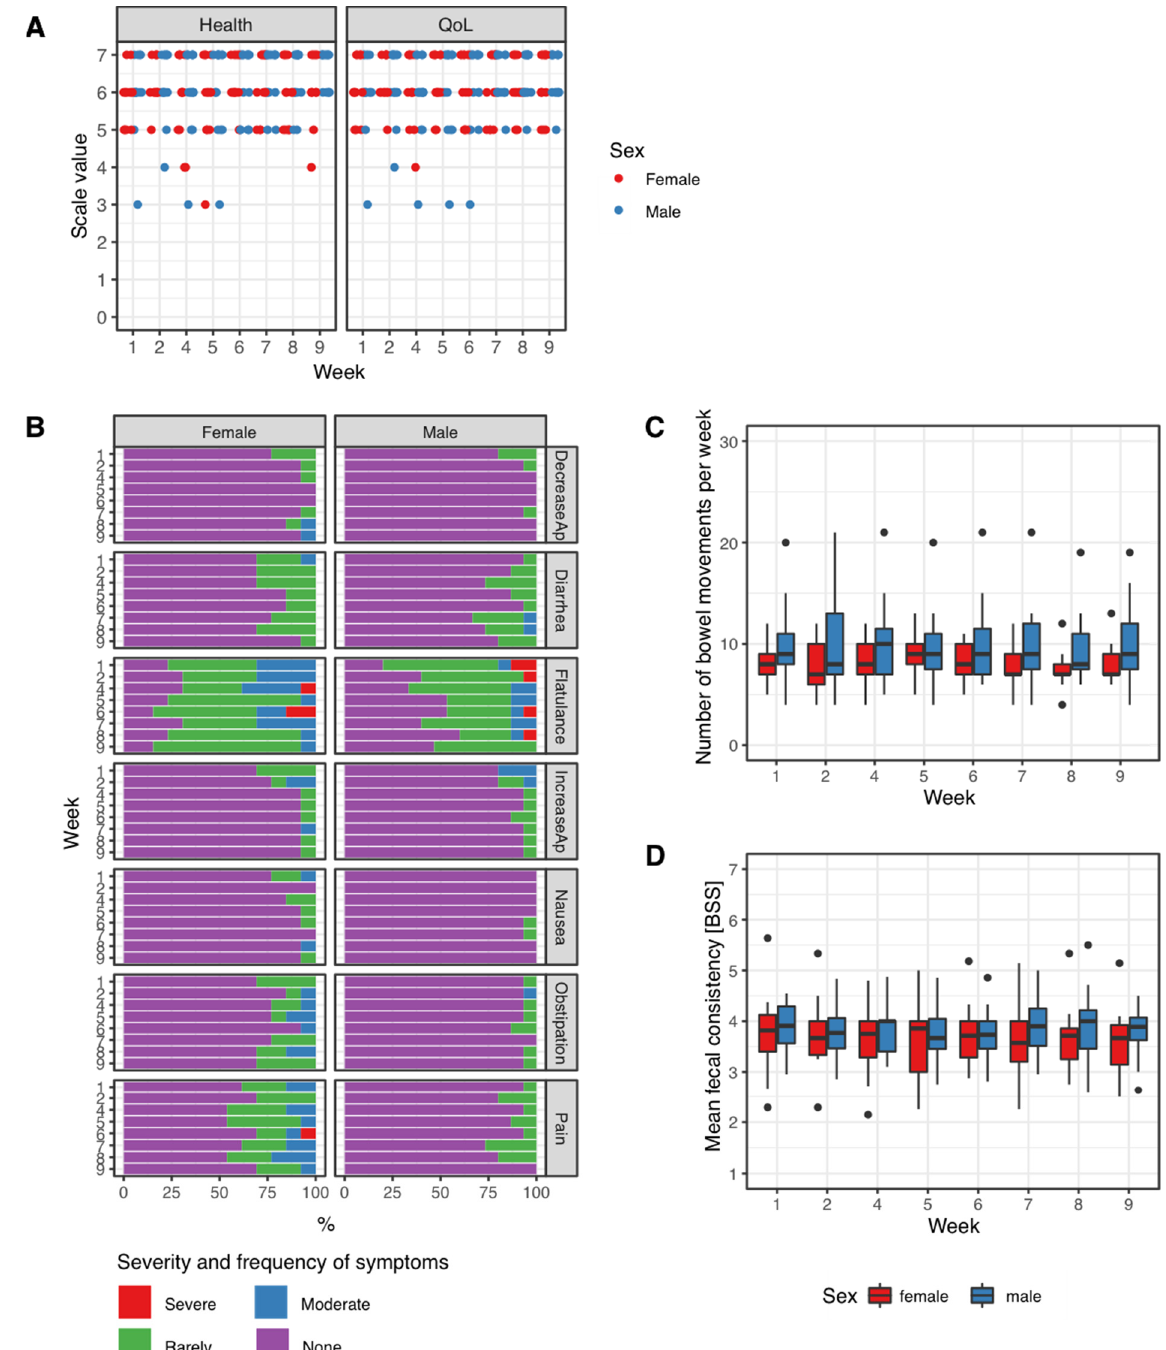
Figure 2. Patient-reported outcomes. ( A ) Weekly scores for health and quality of life (QoL), ( B ) results from weekly symptom-based questionnaires including common gastrointestinal symptoms. ( C ) Number of bowel movements per week in female and male participants. ( D ) Mean fecal consistency, i.e., the Bristol Stool Scale (BSS) value per week. Data were compared by the Kruskal–Wallis test, no significant differences were observed.